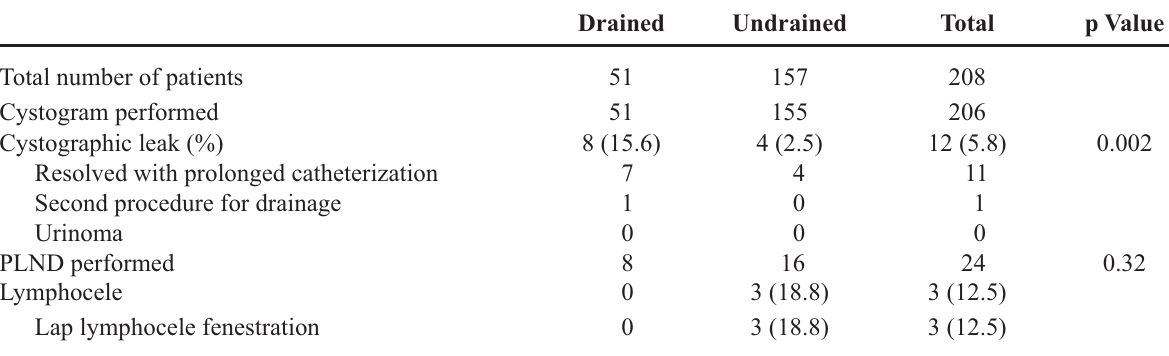
Table 4 – Complication rates, PLND